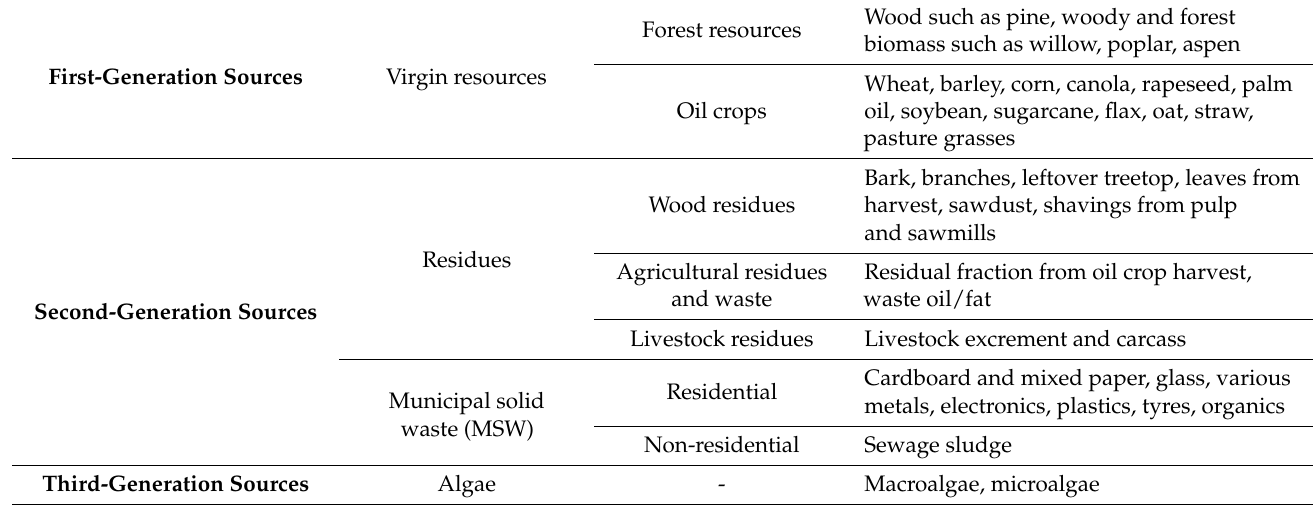
Table 1. Biofuel resource classification (Adapted from [1]).